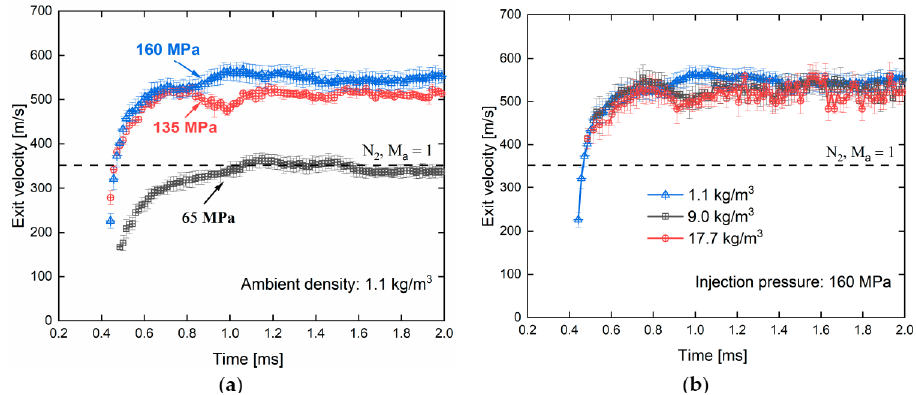
Figure 6. Spray velocities at 2 mm from the nozzle exit. ( a ) Injection pressure e ff ect; ( b ) ambient density e ff ect. M a denotes the sound speed of gas. (Ambient gas condition: N 2 and 297 K; Local sound speed: 354 m /